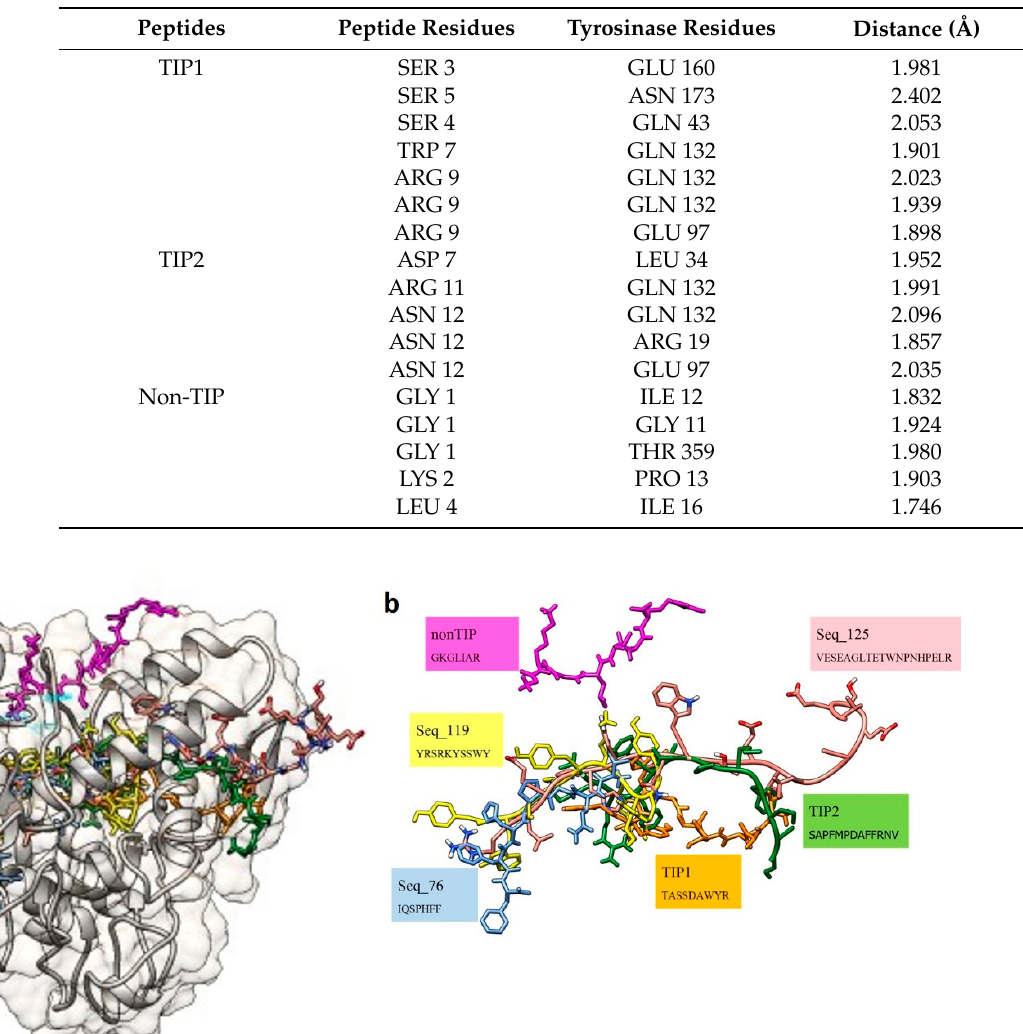
Table 2. List of hydrogen bonds observed from molecular docking of three peptides (TIP1, TIP2, and non-TIP) to the crystal structure of mushroom tyrosinase (PDB ID: 2Y9X).